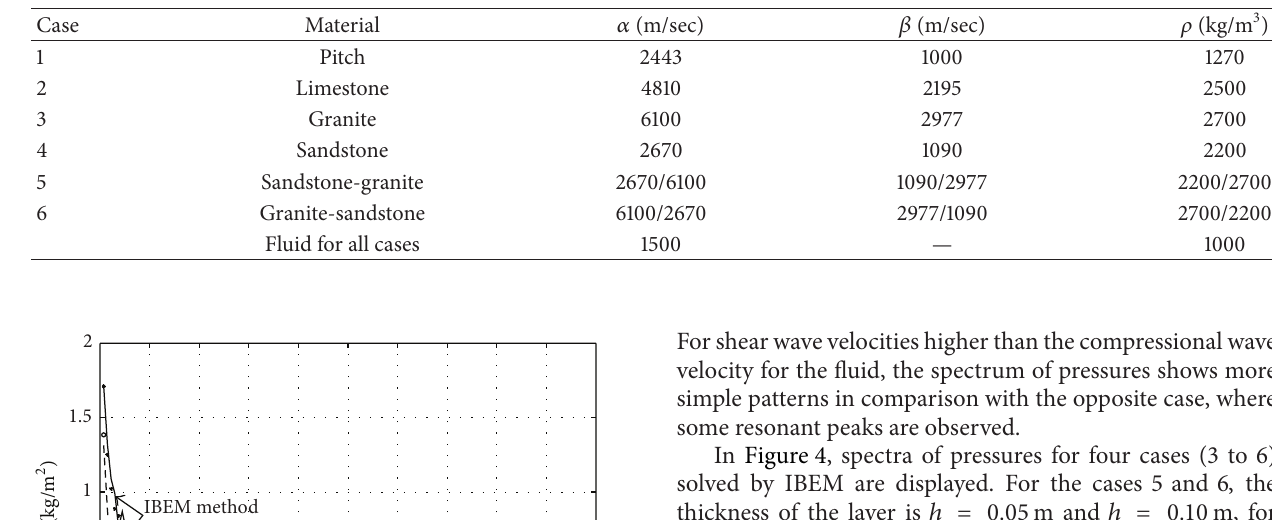
Table 1: Material properties (Borejko [34]) for numerical examples.